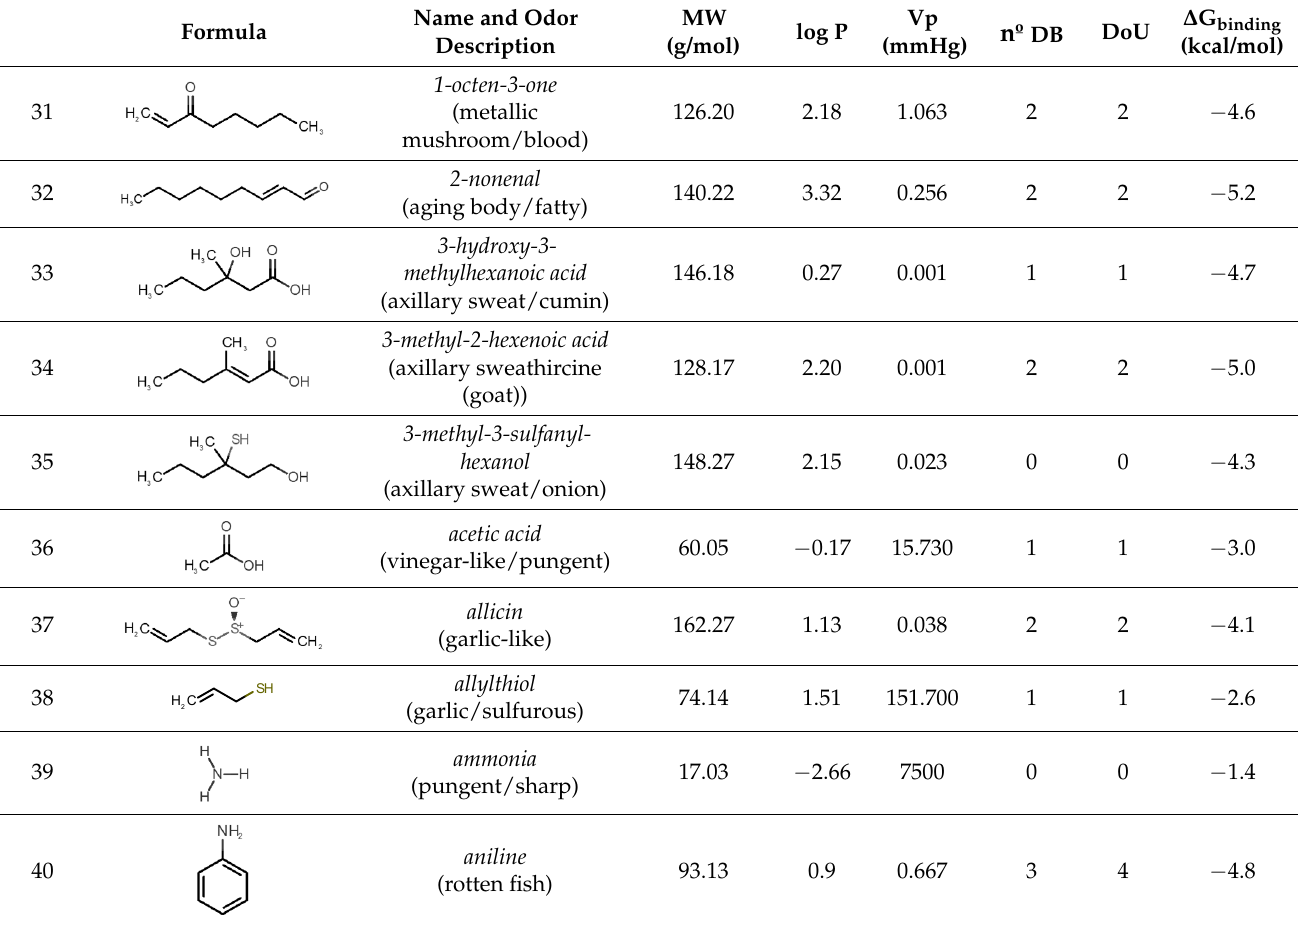
Table 2. Description of unpleasant odorant molecules under study, according to physicochemical and structural characteristics.